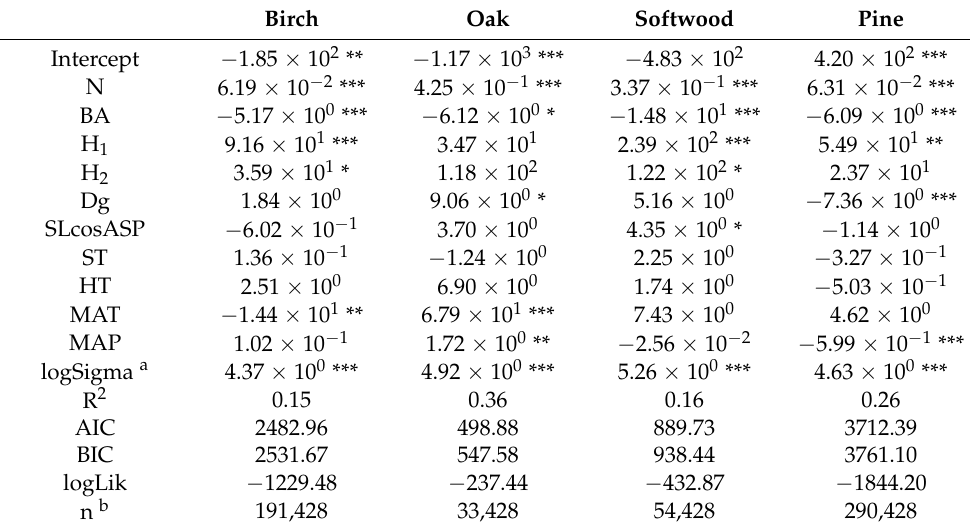
Table 5. The estimated parameters with the lack-of-fit statistics for the recruitment model. The dependent variable, recruitment, was derived in units of trees per hectare every five years. Birch Oak Softwood Pine